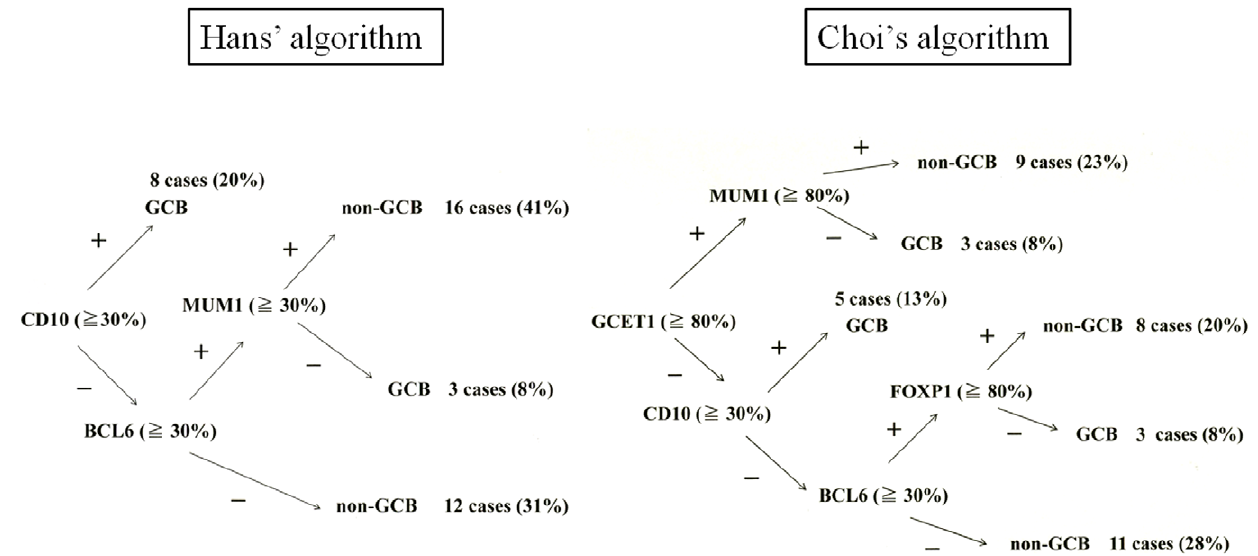
Figure 2. Distribution of GCB and non-GCB type according to Hans et al. and Choi et al.